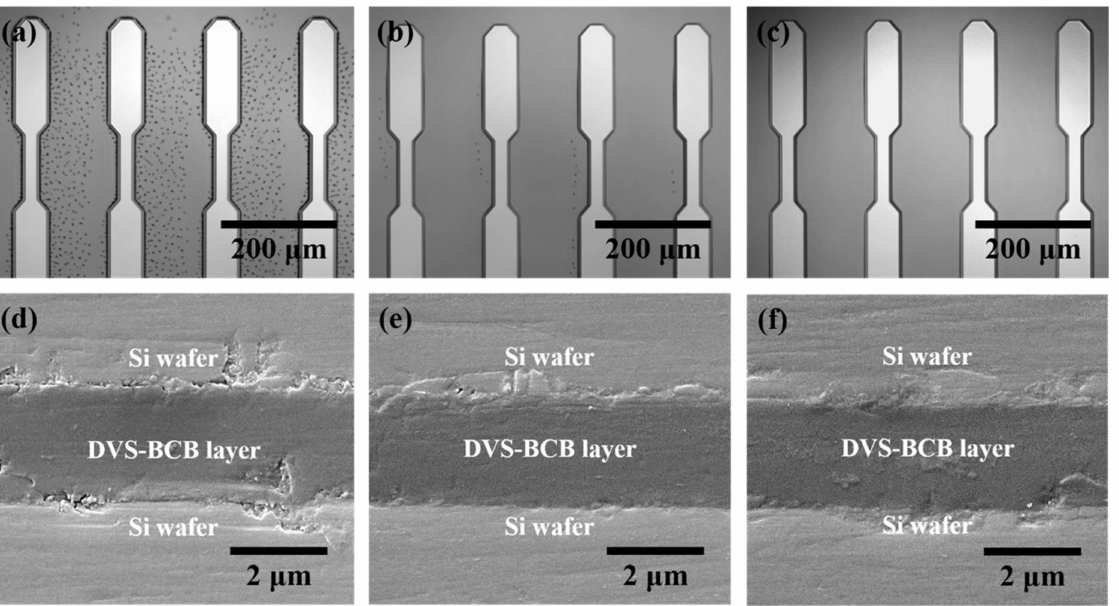
Figure 5. Analysis of the DVS-BCB bonding samples produced by different compressive pressures. ( a – c ) Near-infrared confocal laser microscopic images of the DVS-BCB bonding layer and ( d – f ) cross-sectional SEM images of bonded DVS-BCB bonding